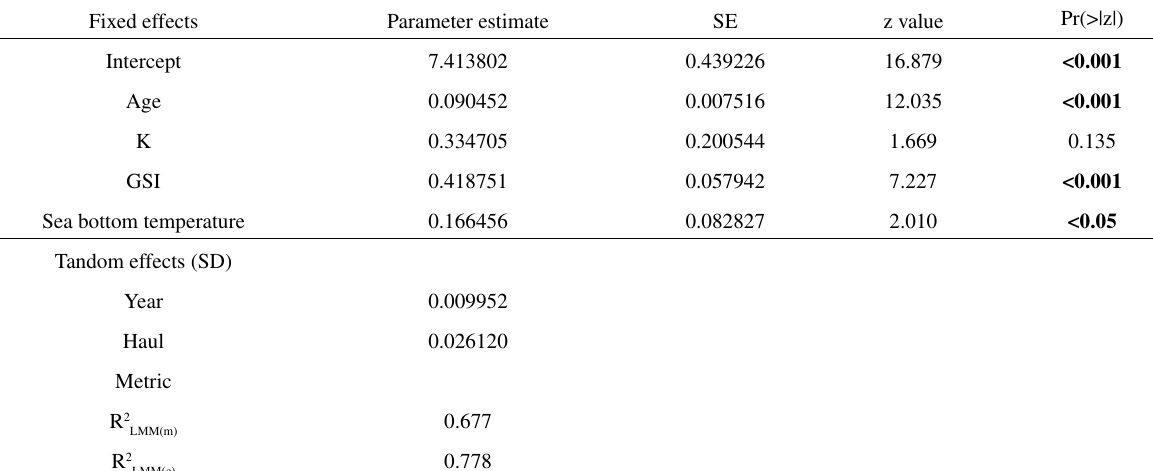
Fig. 6. – Boxplots displaying the relationship of sea bottom temperature with potential fecundity (A) and relative fecundity (B) of S. fasciatus on the Flemish Cap. The relationships of potential fecundity at four different temperatures are shown in C) for length and in D) for age. Table 4. – Parameters of the optimal GLMM using potential fecundity as the response variable and including age, condition factor (K), gonadosomatic index (GSI) and bottom temperature from 21 years (n=280 observations) as explanatory variables. SD, standard deviation; SE, standard error. R2LMM(m) describes the proportion of variance explained by fixed effects alone and R2LMM(c) describes the proportion of variance explained by fixed and random effects